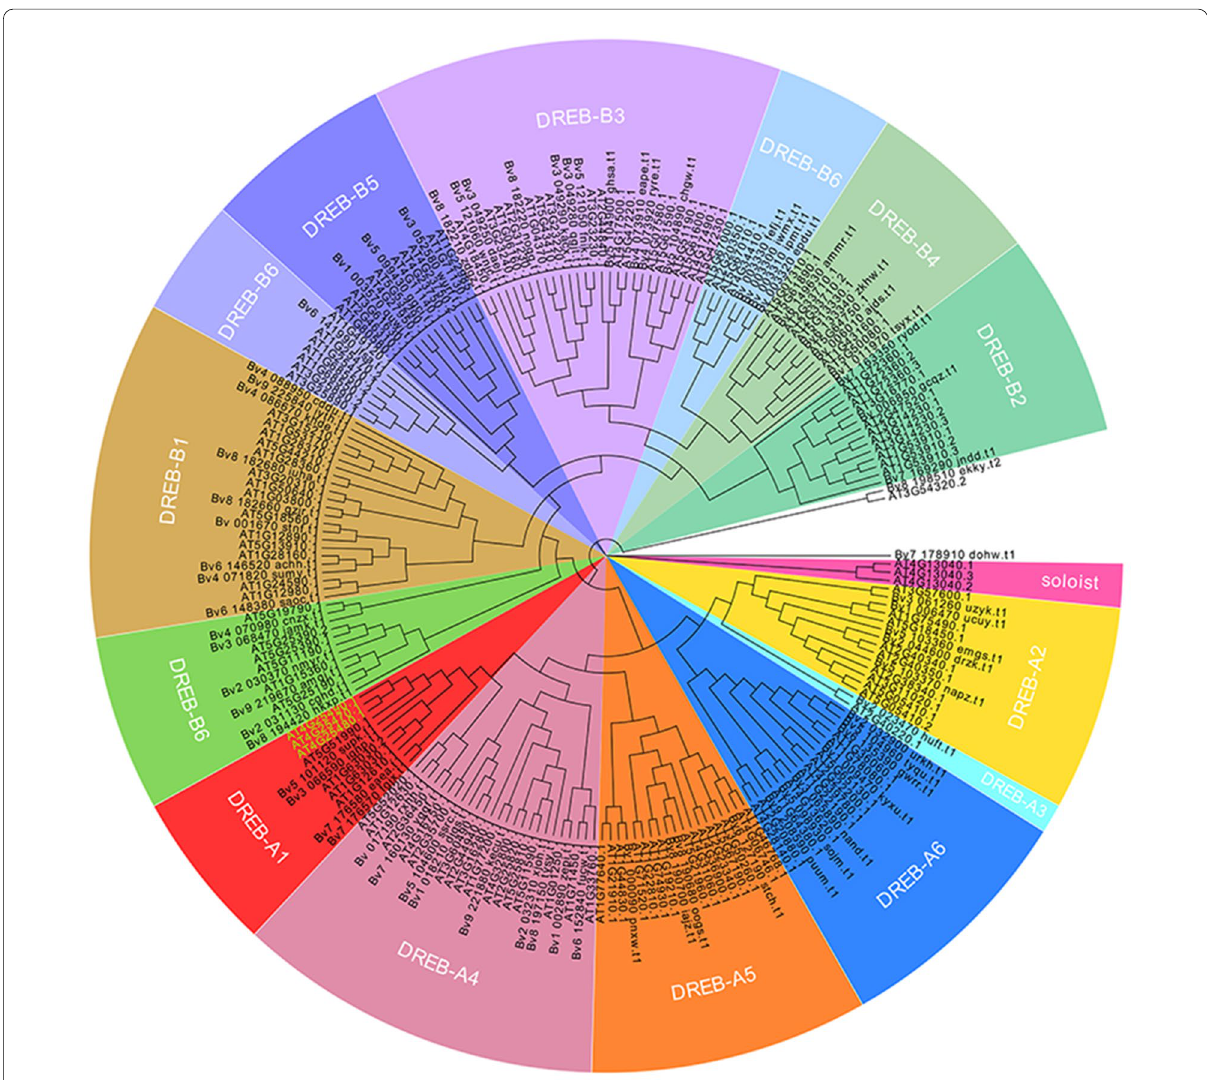
Fig. 2 Phylogenetic analysis of the DREB family in sugar beet. Different background colors indicate different subfamilies, while the green letters in DREB-A1 are AtDREB1A , AtDREB1B and AtDREB1C ,